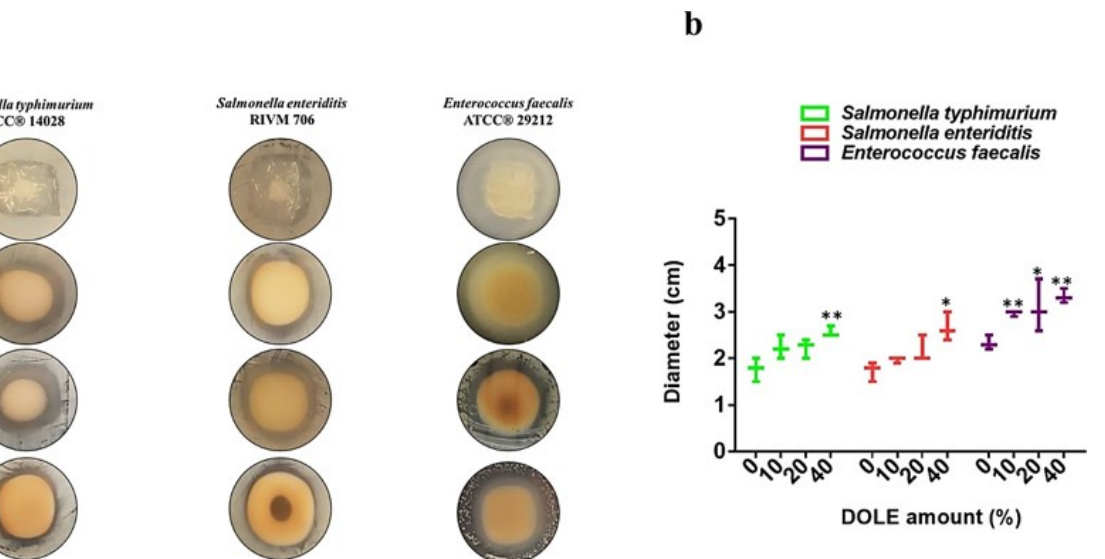
Figure 6. Antimicrobial activity of DOLE-based films. Antimicrobial effects were evaluated by analyzing the growth of the bacterial cells held in direct contact with the films ( a ). The diameter of the inhibition circle was determined for each bacterial strain in contact with the different films and shown in the graph ( b ). The experiments were carried out in triplicate. Statistical analyses were performed by using Student’s t -test. Significant differences were indicated as * p < 0.05 or ** p < 0.01.